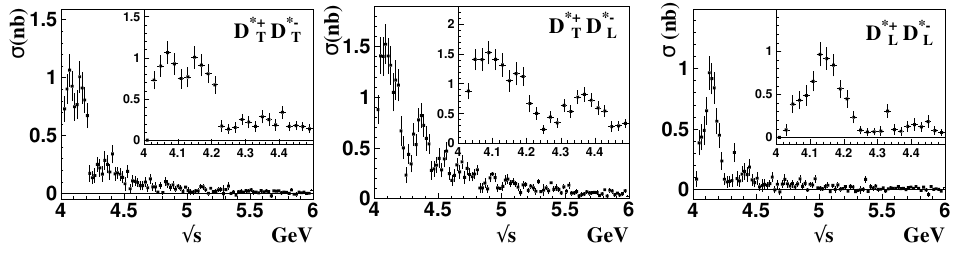
Figure 3. The components of the e + e − helicity: left is transverse; right is longitudinal.